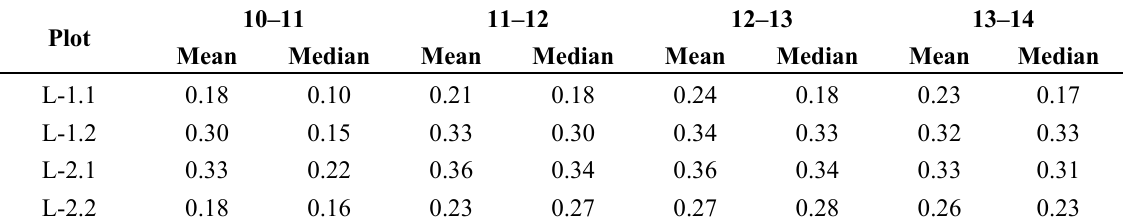
Table 3. Mean and median CWSI for each one-hour period during the 29 days of